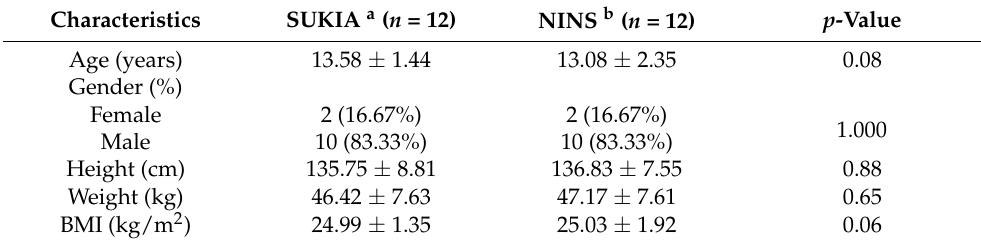
Table 2. Demographic characteristics of participants.